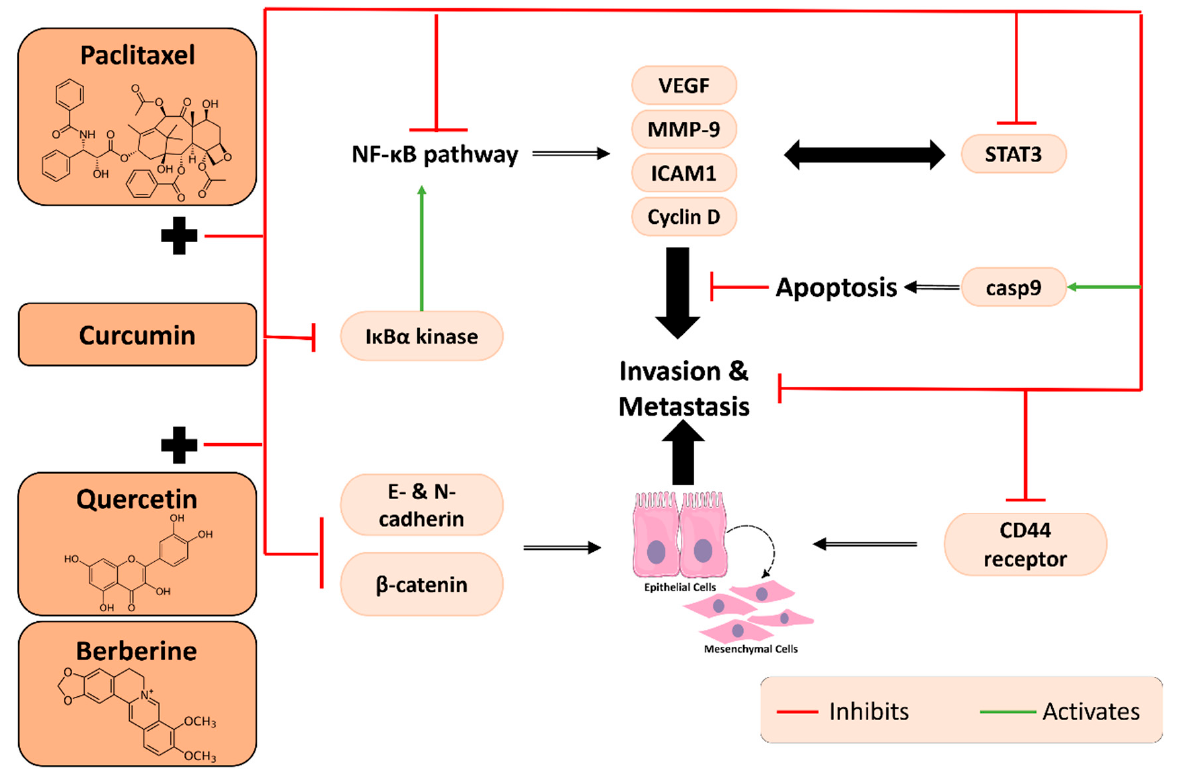
Figure 5. Molecular pathways underlying the anti-metastatic and anti-invasive properties of curcumin in combination with paclitaxel or with quercetin and berberine.